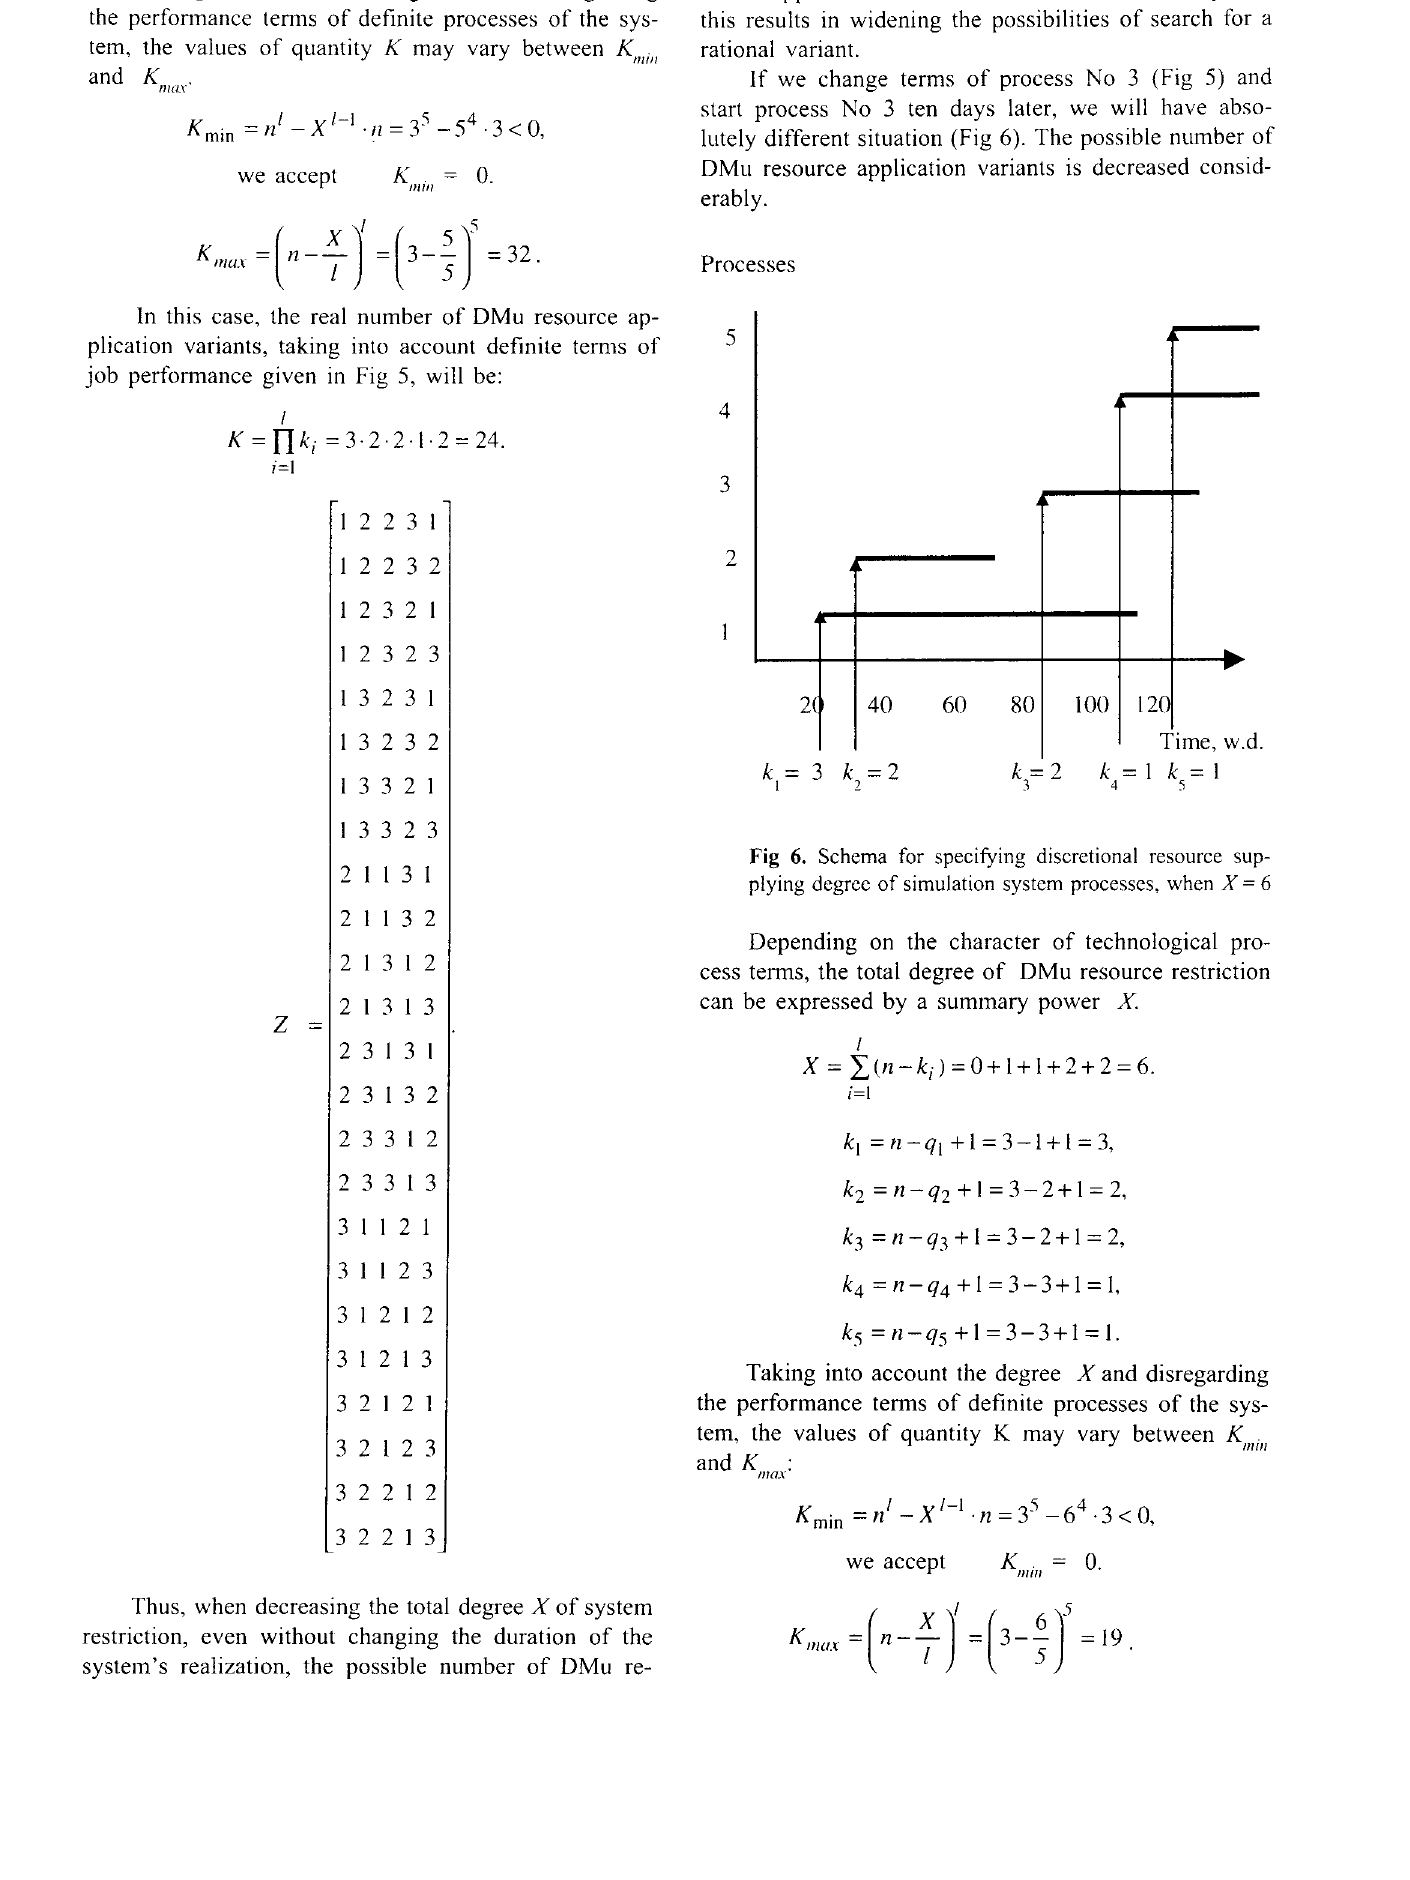
Fig 6. Schema for specifying discretional resource sup plying degree of simulation system processes, when X= 6 Depending on the character of technological pro cess terms, the total degree of DMu resource